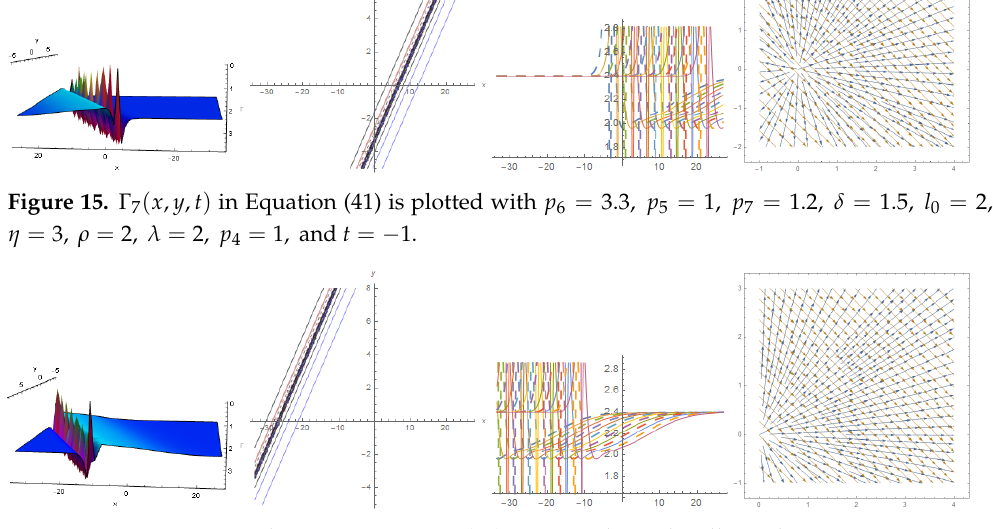
Figure 16. Interaction solution in Equation (41) presented graphically with p 6 = 3.3, p 5 = 1, p 7 = 1.2, δ = 1.5, l 0 = 2, η = 3, ρ = 2, λ = 2, p 4 = 1, and t = 3.